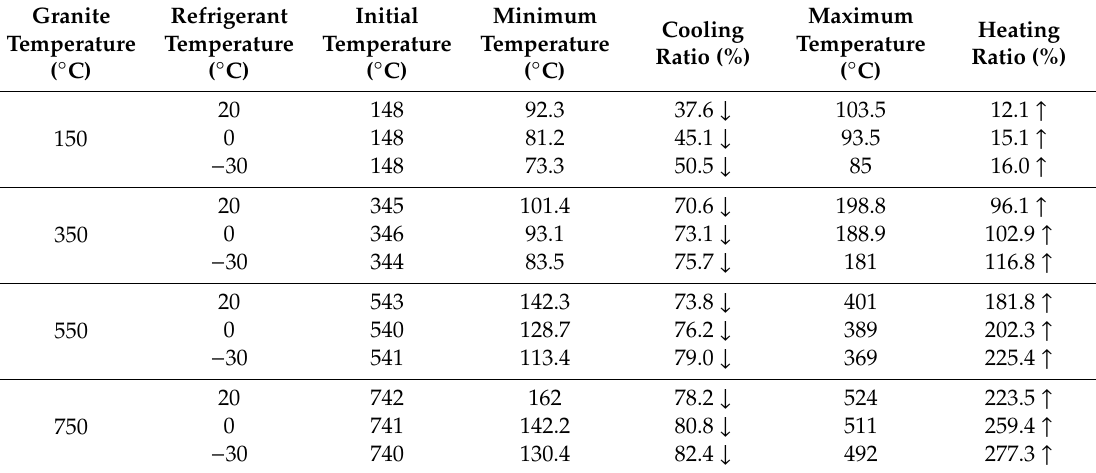
Table 2. Statistical results of the temperature change of samples under di ff erent cooling